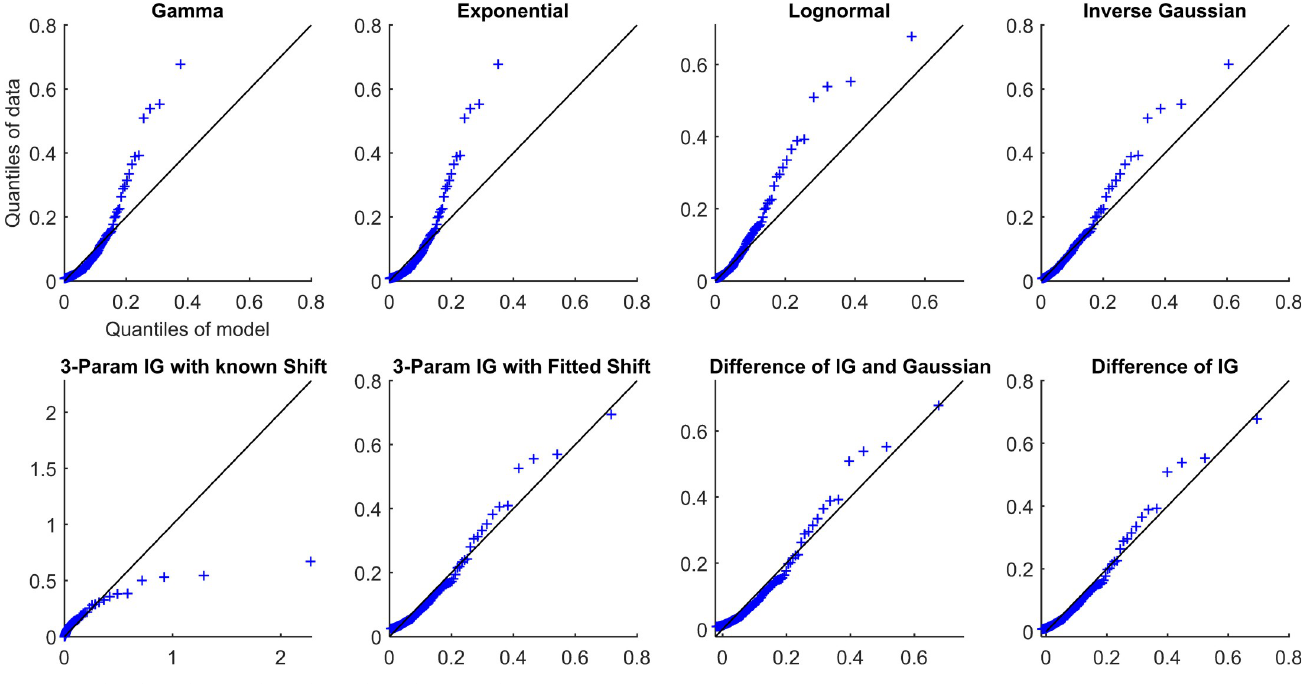
Fig 2. QQ plots for Subject S8 from the awake and at rest cohort.